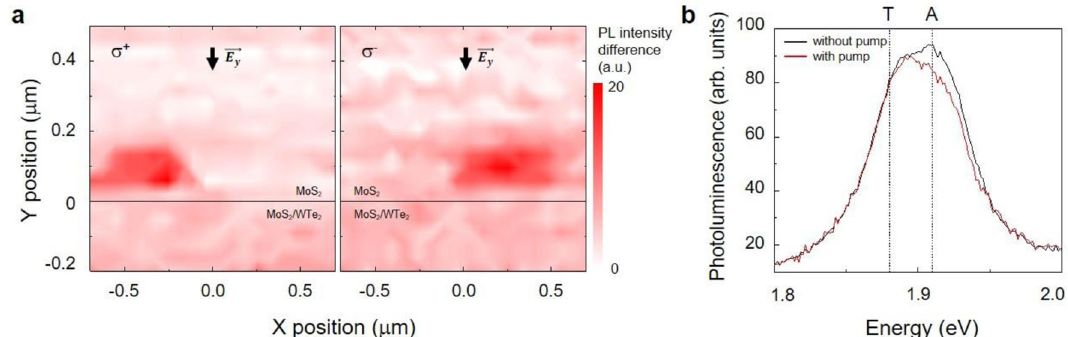
Fig. 2 Scanning differential PL measurements across the MoS 2 /WTe 2 edge boundary. The A exciton PL signal of MoS 2 is suppressed by the electron transfer from WTe 2 . a The spatially resolved 2D PL intensity of the MoS 2 A exciton ( V G = 2 V) is shown for the remote pump with σ + polarization (left) and σ − polarization (right). The center of the remote pump excitation with the 2 μ m waist is fi xed at (0, − 0.2) μ m. The edge of the WTe 2 ! monolayer is located at the solid black line ( y = 0 μ m) and the longitudinal electrical bias E y is applied in the direction of the black arrow. b PL spectrum at (0.25, 0.1) μ m, with (red) and without (black) the pump pulse is shown. T and A stand for the trion and the A exciton of MoS 2 ,